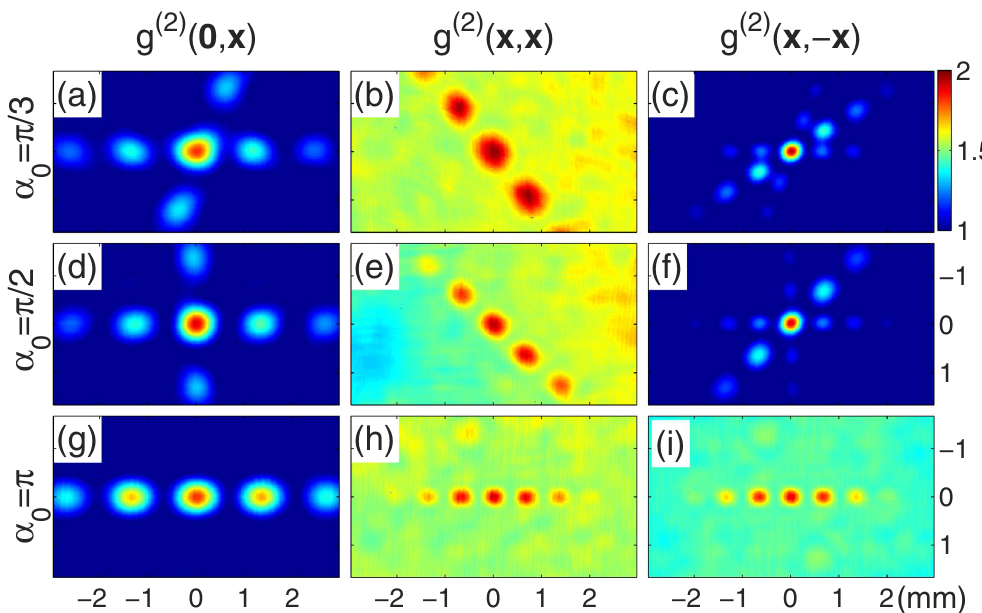
→ Figure 2. Experimental results of two-dimensional intensity correlation functions. In ( a , d , g ), g x (0, ) (2) is → → measured for α 0 = π /3, π /2, and π respectively. In ( b , e , h ), g x x ( , ) (2) is measured for α 0 = π /3, π /2, and π → −→ respectively. In ( c , f , i ), g x x ( , ) (2) is measured for α 0 = π /3, π /2, and π respectively. Each pattern is obtained by averaging 10,000 CCD